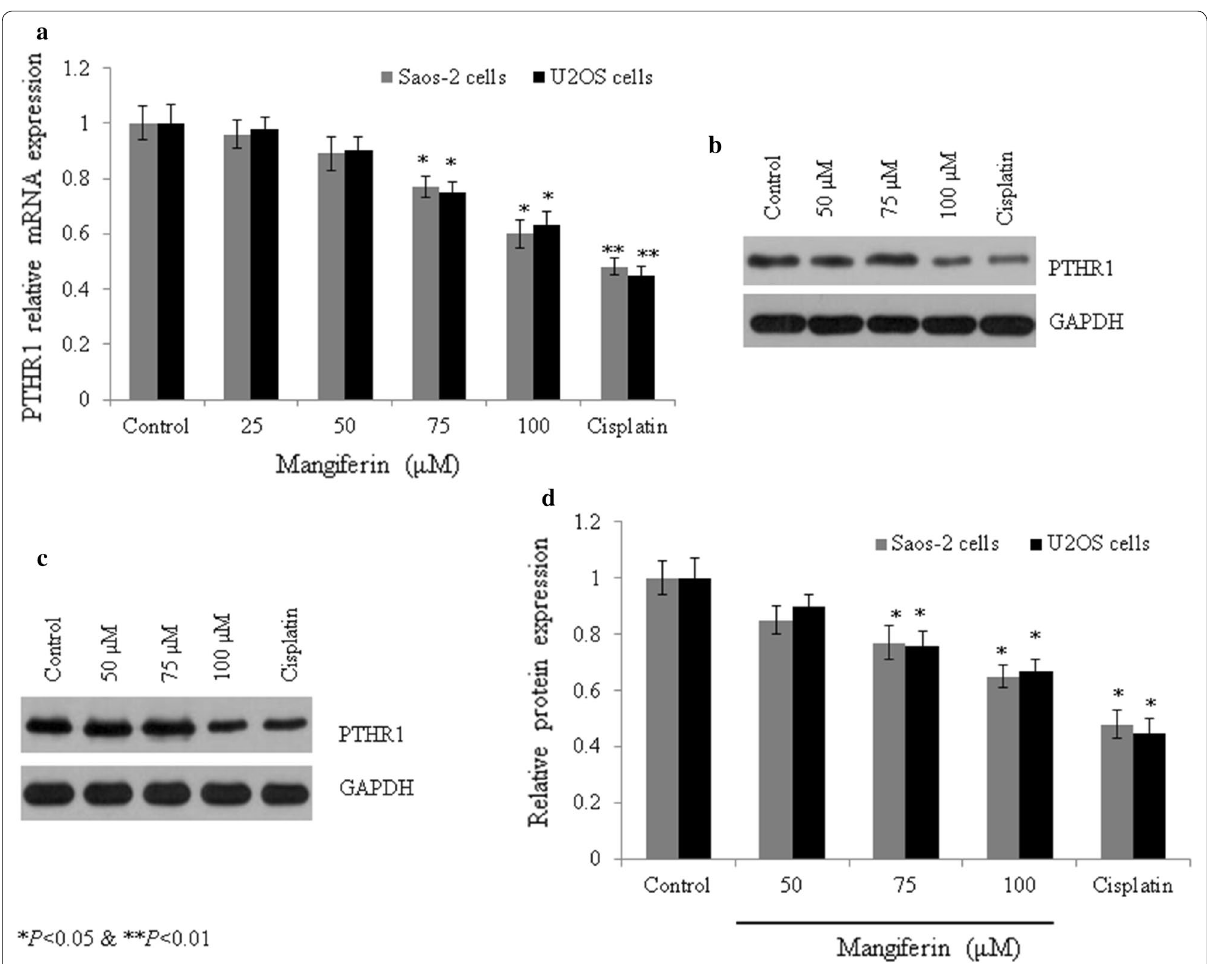
Fig. 7 Mangiferin effect on the mRNA and protein expression of PTHR1 in osteosarcoma cells. Cells were incubated with mangiferin (50–100 µM) for 72 h. a mRNA expression of PTHR1 in Saos-2 and U2OS cells, b western blot bands of PTHR1 in Saos-2 cells, c western blot bands of PTHR1 in U2OS cells. d Densitometry analysis of b and c . N 6. Control vs. * P < =